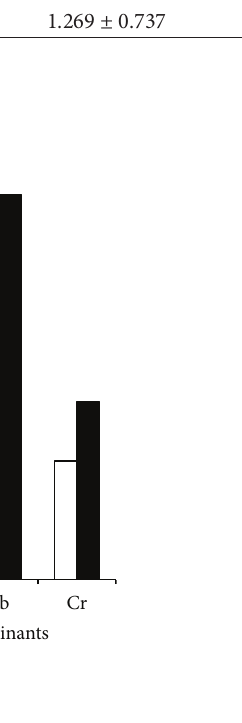
Figure 3: Comparison between local and imported cigarette brands in smoke.